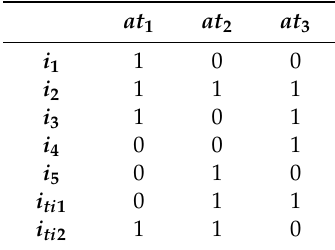
Table 3. Example of item attribute information